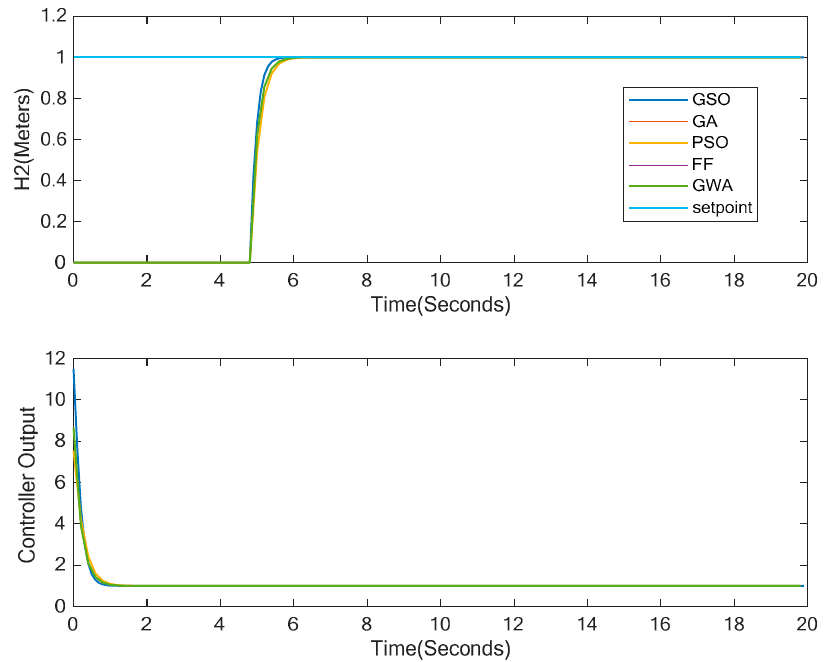
Figure 10. Example 1: Servo response with the RTD-A controller using two tuning methods.